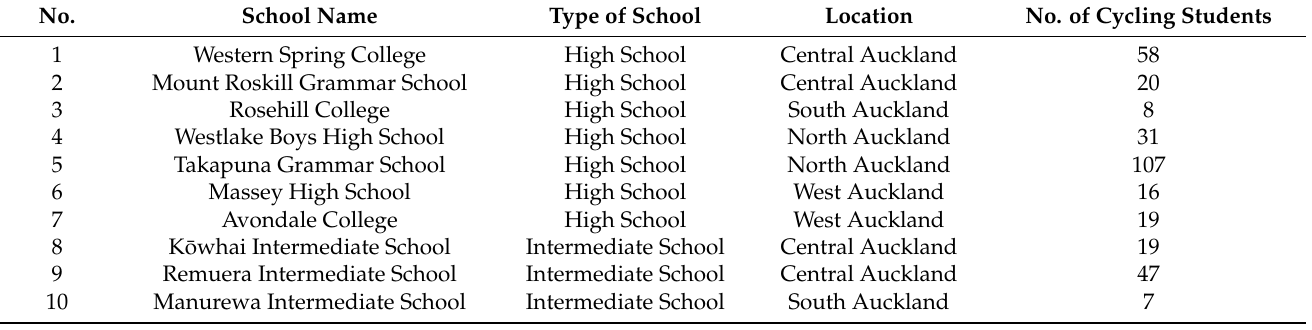
Table 1. General information of schools involved in the study.